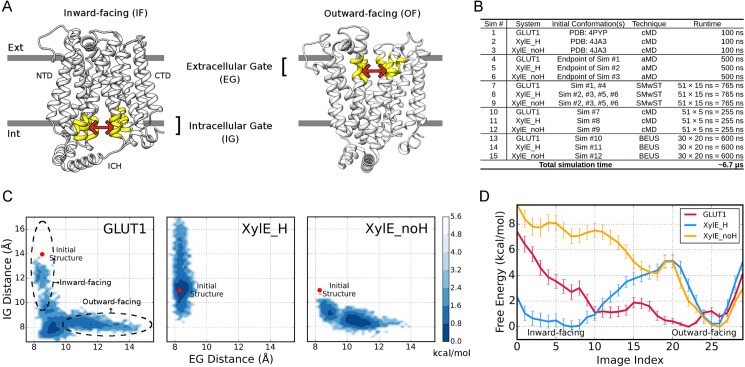
Conformation sampling and free energies of GLUT1, XylE_H and XylE_noH.(A) The definitions of extracellular and intracellular gates. Extracellular gate (EG) comprises of two groups of interacting helices at periplasmic side, including TM 1, 2&5 and TM 7, 8&11 (highlighted in yellow). Likewise, cytoplasmic portions of TM 2, 4&5 and TM 8, 10&11 compose the intracellular gate (IG) residues. The centers of mass (COM) of Cα atoms in the two gating groups are used to depict gate distances. (B) List of simulation sets performed on GLUT1, XylE_H and XylE_noH systems. (C) The unweighted contour maps for aMD trajectories in the 2D space of Extracellular and Intracellular Gate distances. The positions of initial structures for GLUT1 (PDB ID: 4PYP) and XylE systems (PDB ID: 4JA3) are shown as red dots. Dashed circles denote the supposed regions of inward- and outward-facing conformations. (D) Free energy profiles along discretized BEUS images/windows. GLUT1, XylE_H and XylE_noH are colored red, blue and yellow, respectively.